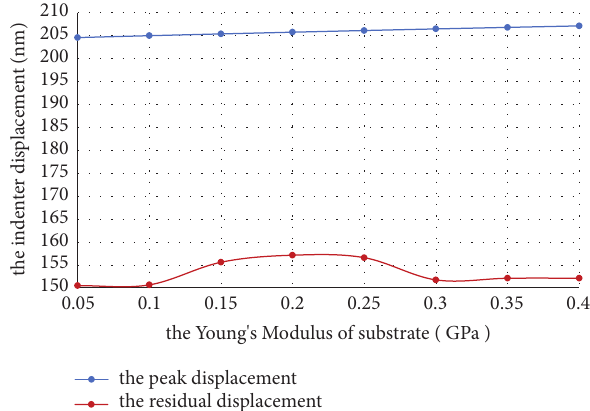
Figure 7: The relationship between displacement and μ